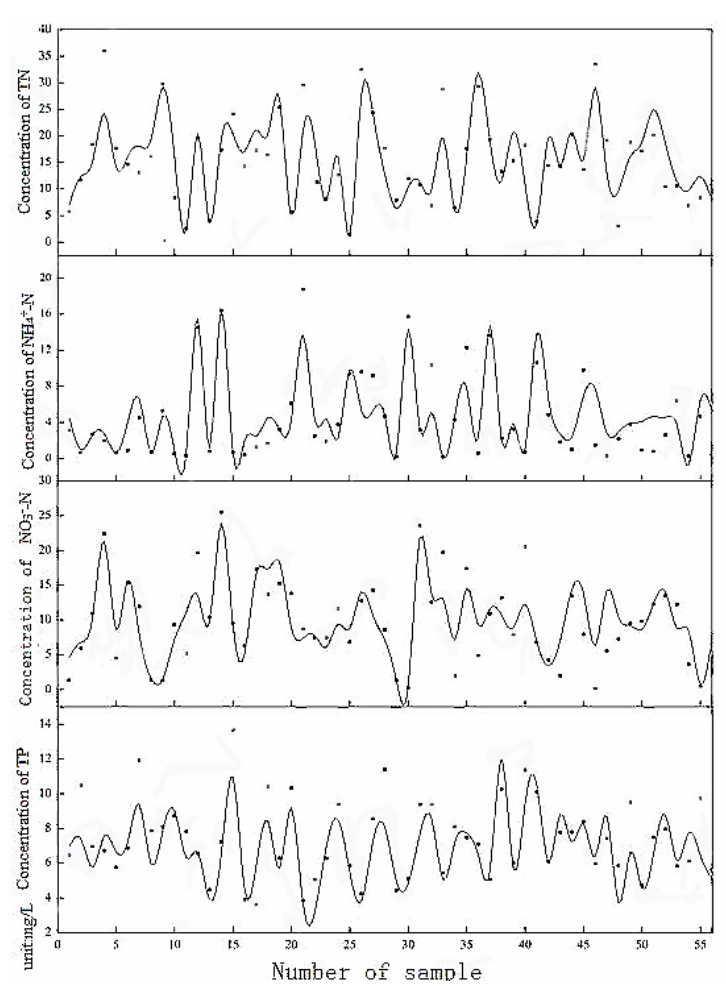
Figure 9. Fitting curve values and model output values.